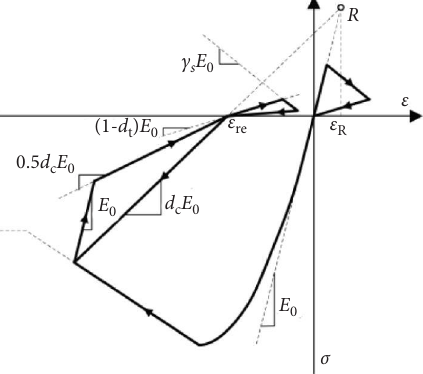
Figure 3: Rebar constitutive